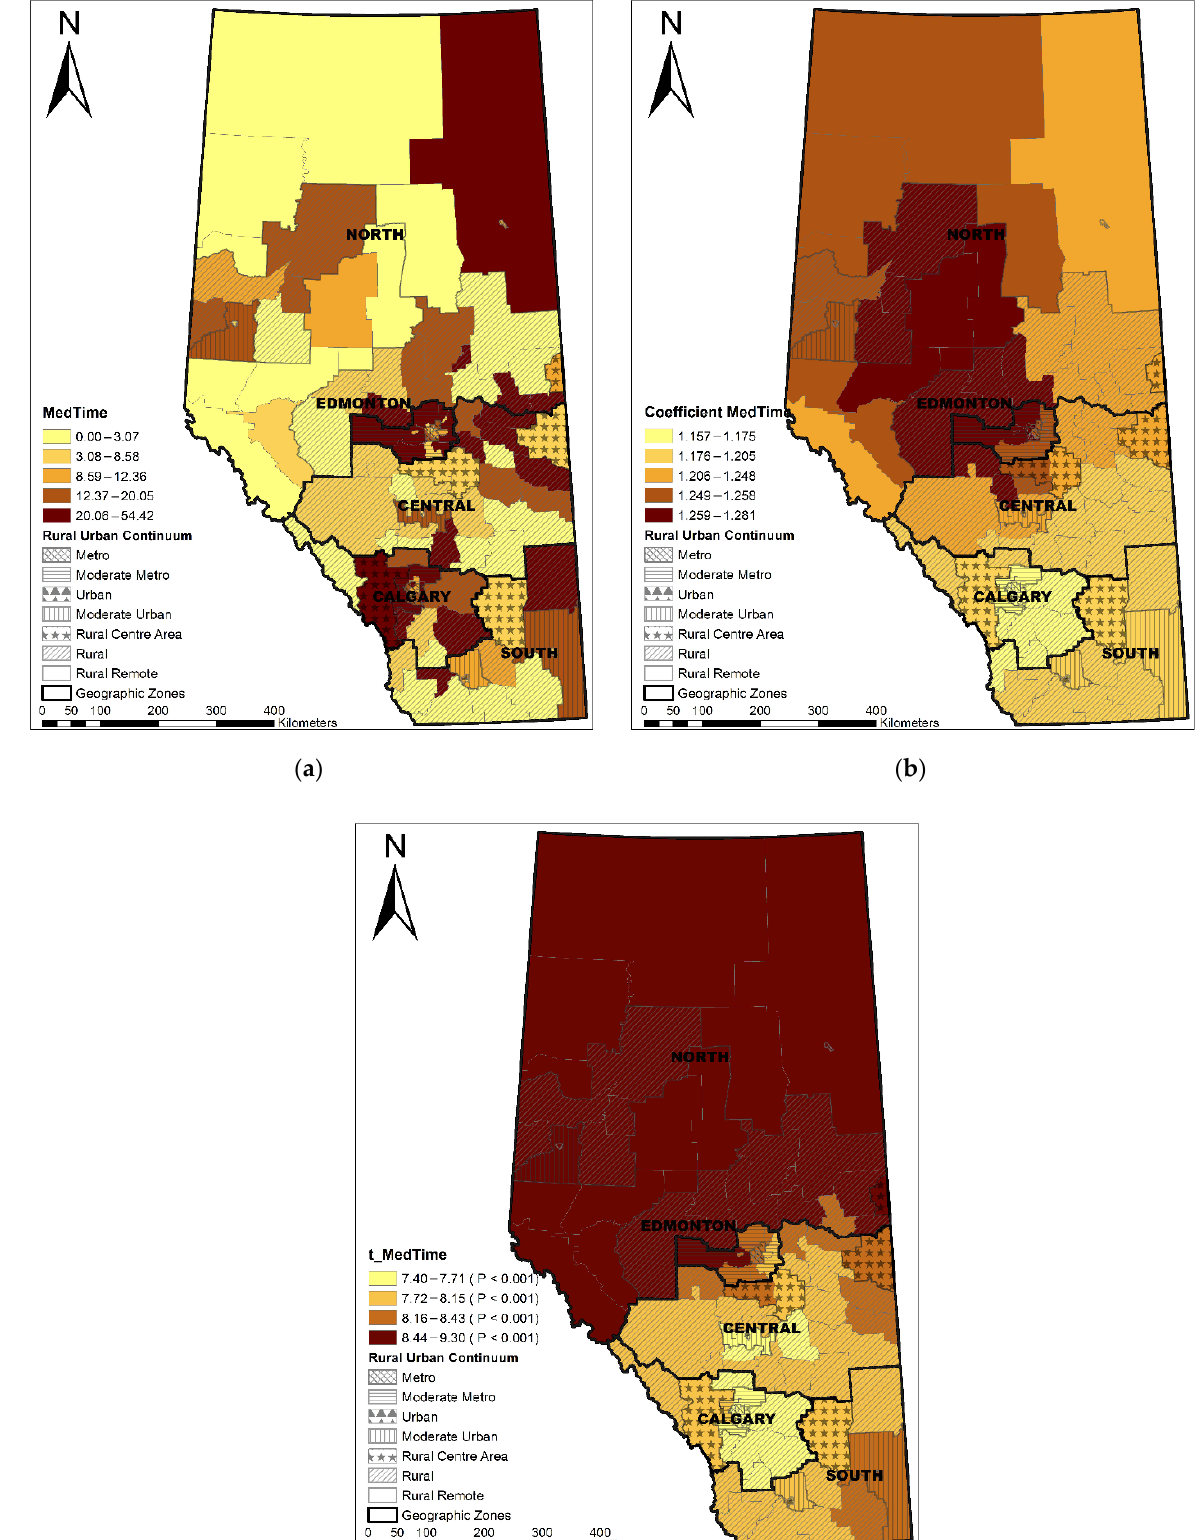
Figure 4. Distribution of median travel time ( a ), coefficient of median travel time ( b ), and significance of coefficient ( c ).